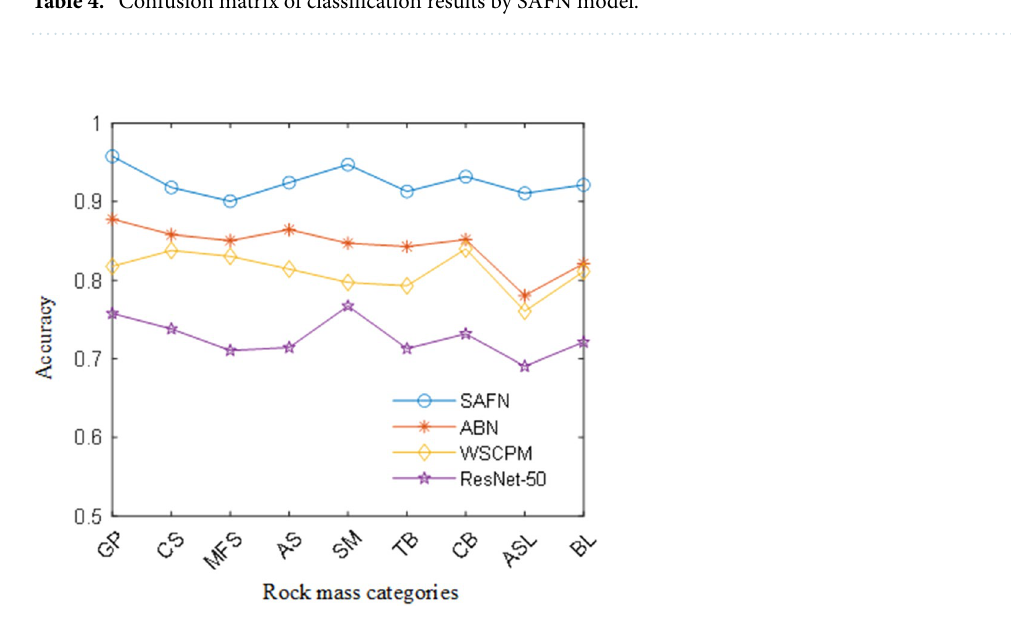
Figure 10. Geological distribution of the sampling